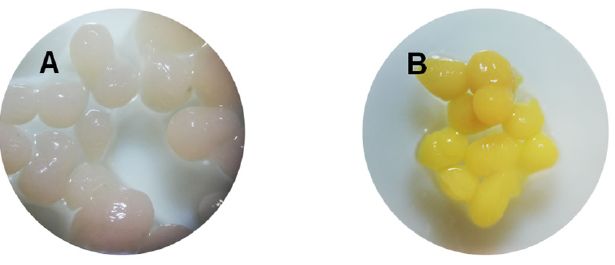
Figure 2. Photographs of the synthesized biosorbent before adsorption ( A ) and after adsorption ( B ) of Ethacridine lactate from aqueous solution.